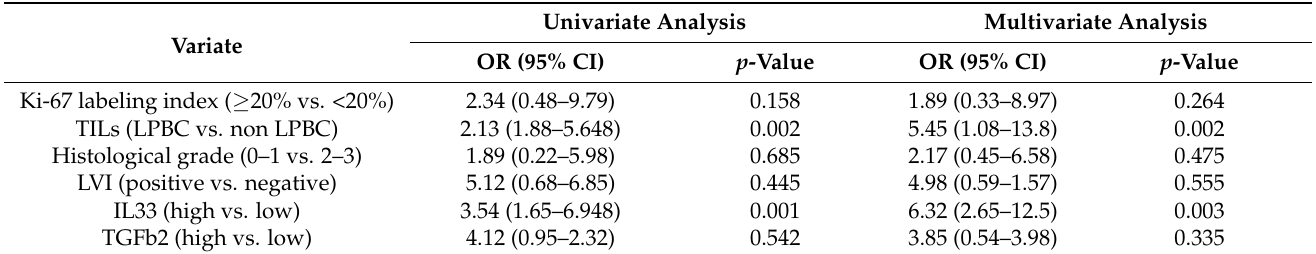
Table 2. Univariate and multivariate analyses for predicting pathological complete response in TNBC.